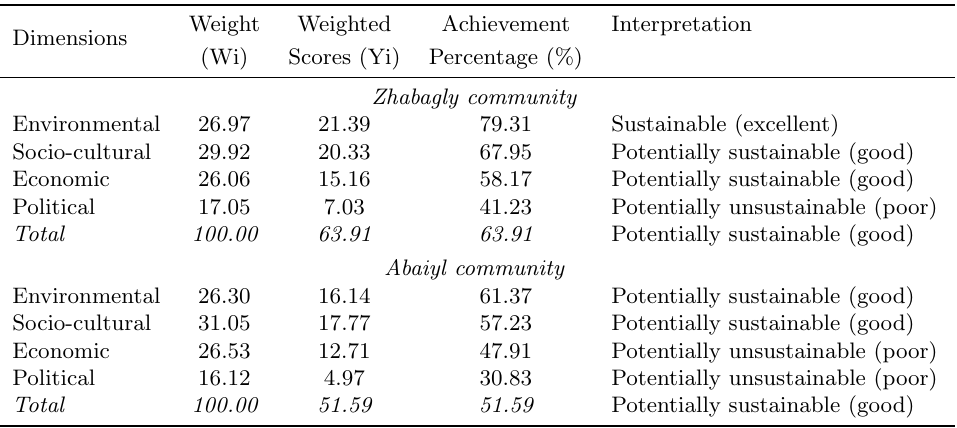
Figure 3: Implementation of CBE development in Aksu-Zhabagly NR. Table 3: Sustainability achievement of Zhabagly and Abaiyl communities in inter- relationship